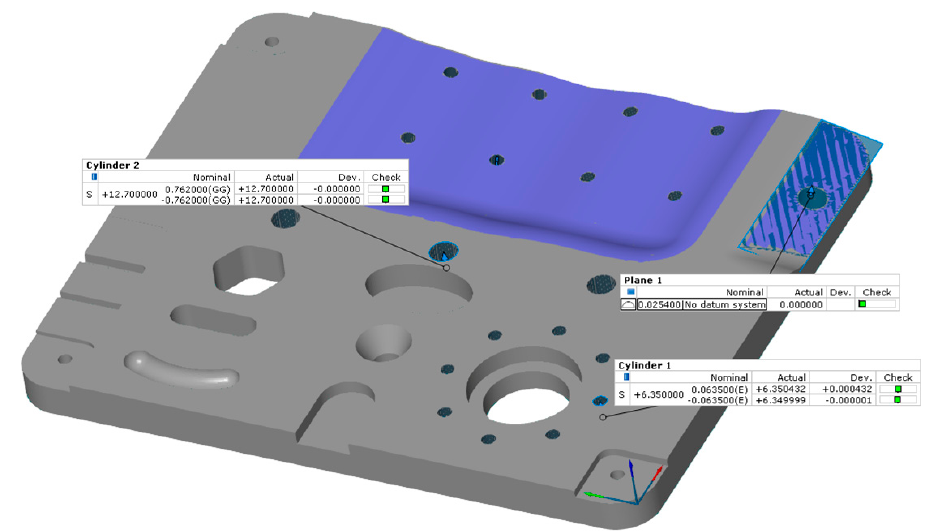
Figure 6. GD&T evaluation (real and nominal values) and representation on the CAD model.